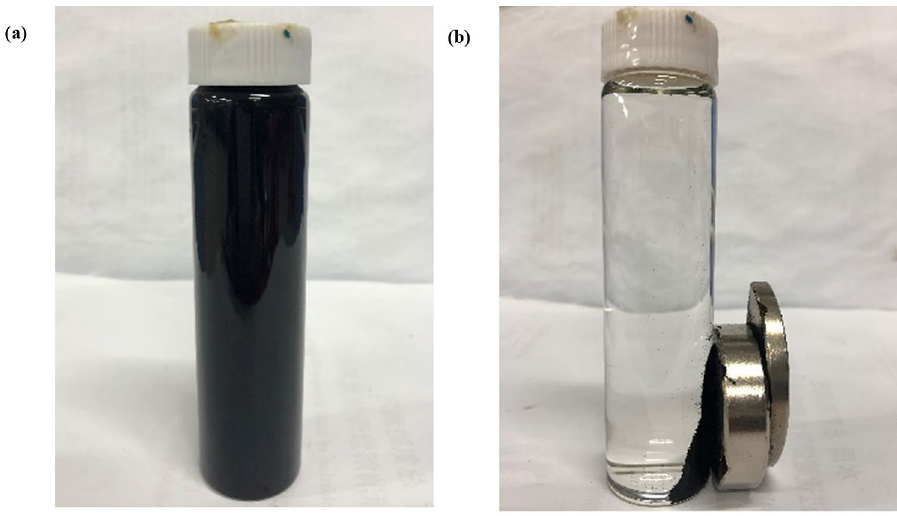
Figure 9. Comparison of solid–liquid separation effects between lignite and MML. ( a ) Lignite; ( b )